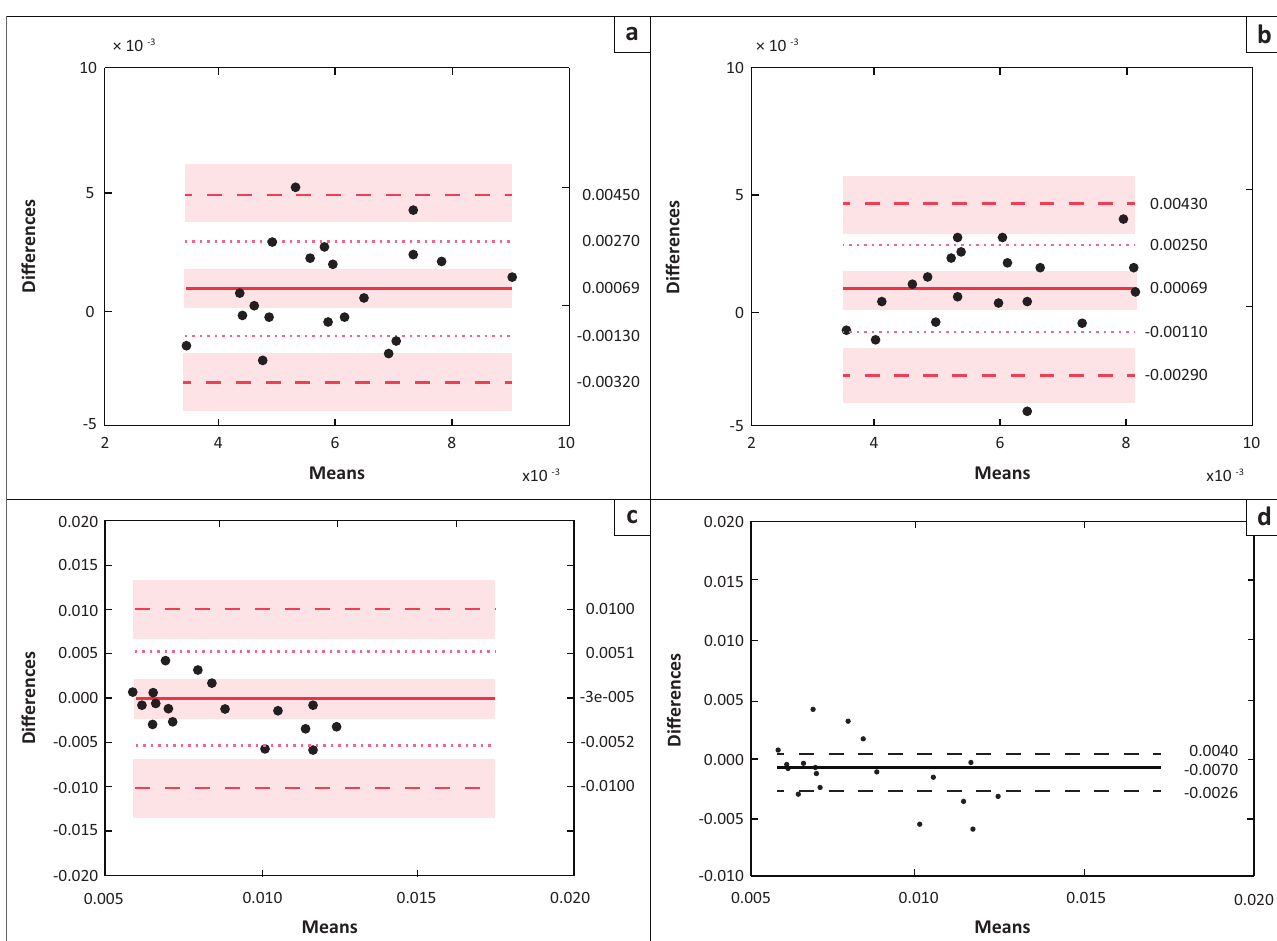
FIGURE 5: Bland–Altman plots of means versus differences and 95 % limits of agreement (LoA) of test and retest for (a) protan, (b) deutan and (c) tritan CCT trivectors for 20 right eyes. Because of an outlier (see the point near the top of the plot), the plot for the tritan results has different scales. As a result, a non-parametric Bland–Altman plot of medians and 95 % LoA for the non-normally distributed tritan differences was drawn for this sample and is shown in